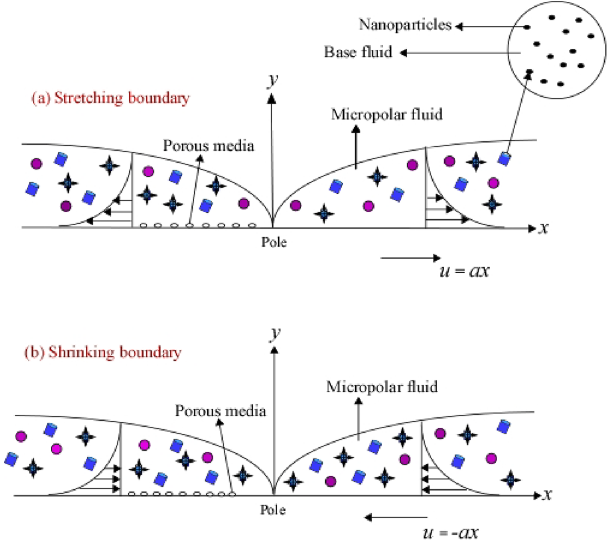
Figure 1. Schematic representation of the stretching/shrinking